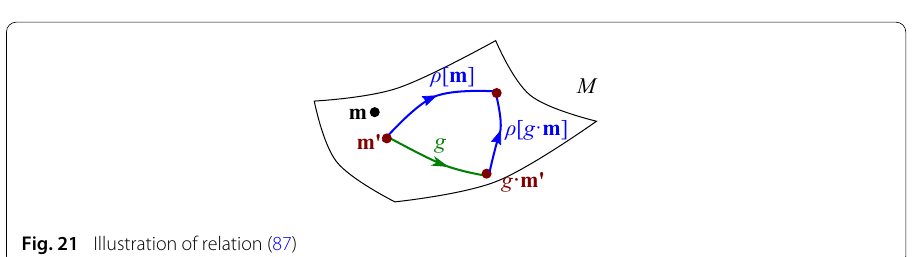
Fig. 21 Illustration of relation